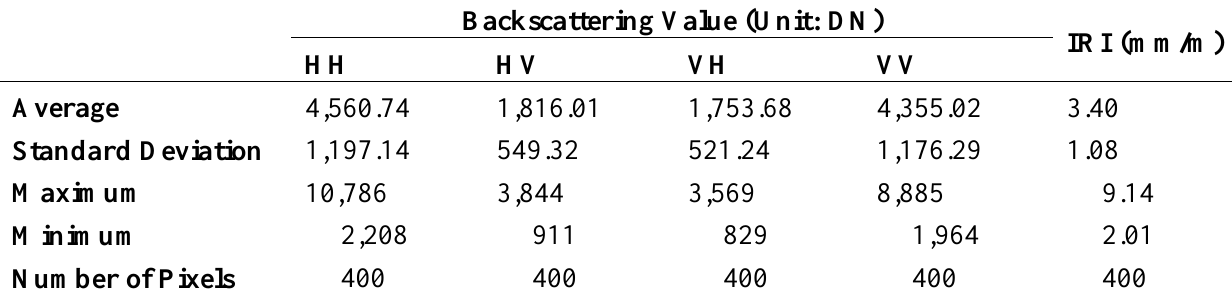
Table 3. Basic statistical values along the ACC highway sampled.